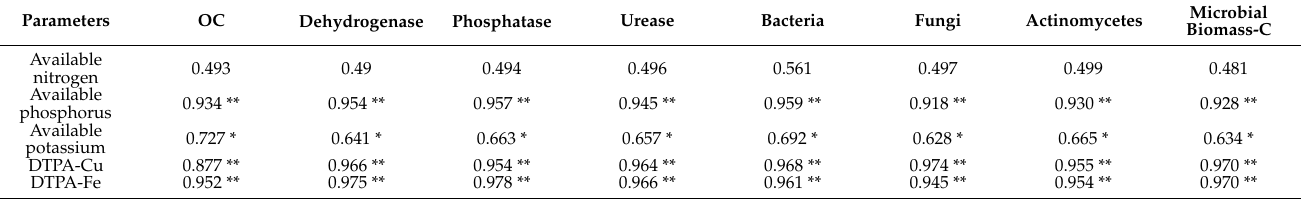
Table 8. Correlation of soil biological properties with nutrient contents in